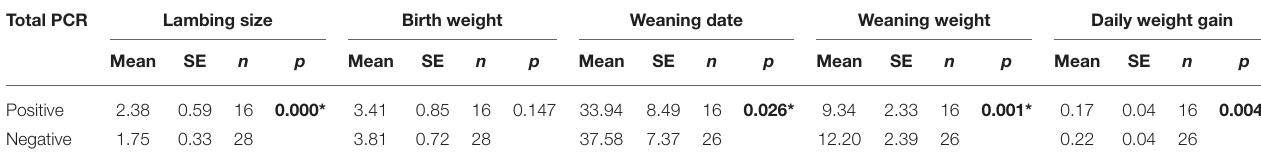
TABLE 5 | Meat production parameters in ELISA-positive animals from Flocks A and B of the Raza Navarra breed according to PCR infection status. Total PCR Lambing size Birth weight Weaning date Weaning weight Daily weight